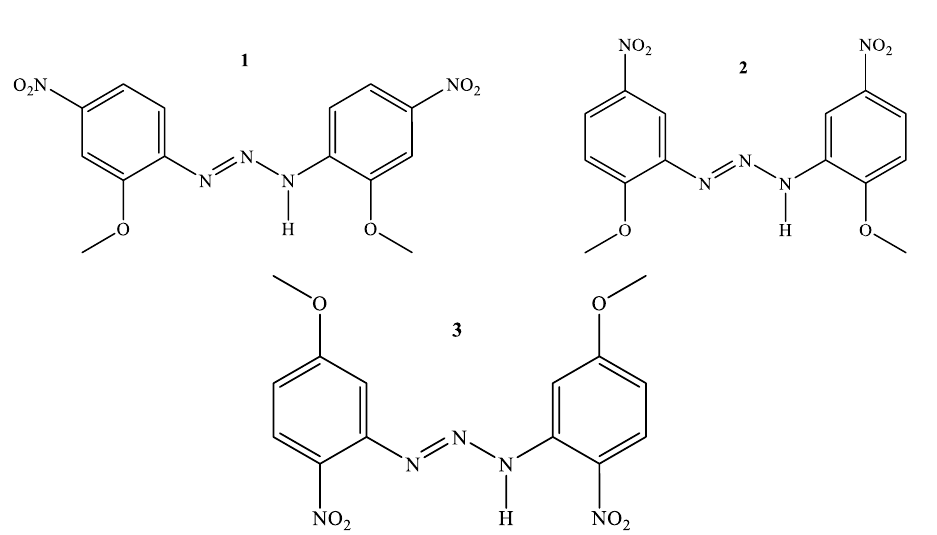
Figure 2. The structures of 1,3-diaryltriazenes (1) 1,3- bis (2-methoxy-4-nitrophenyl)triazene, (2) 1,3- bis (2- methoxy-5-nitrophenyl)triazene, and (3) 1,3- bis